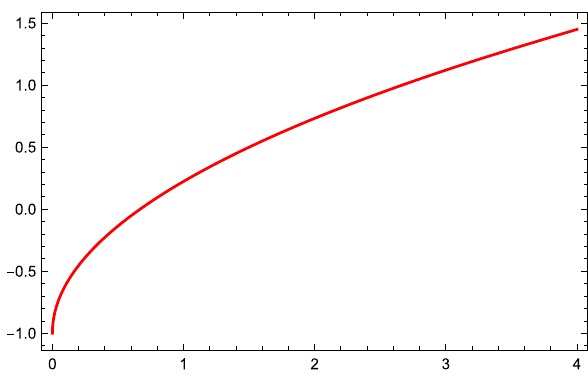
expansion Universe is accelerated and for q ( z ) = 0 shows that the Universe is marginal